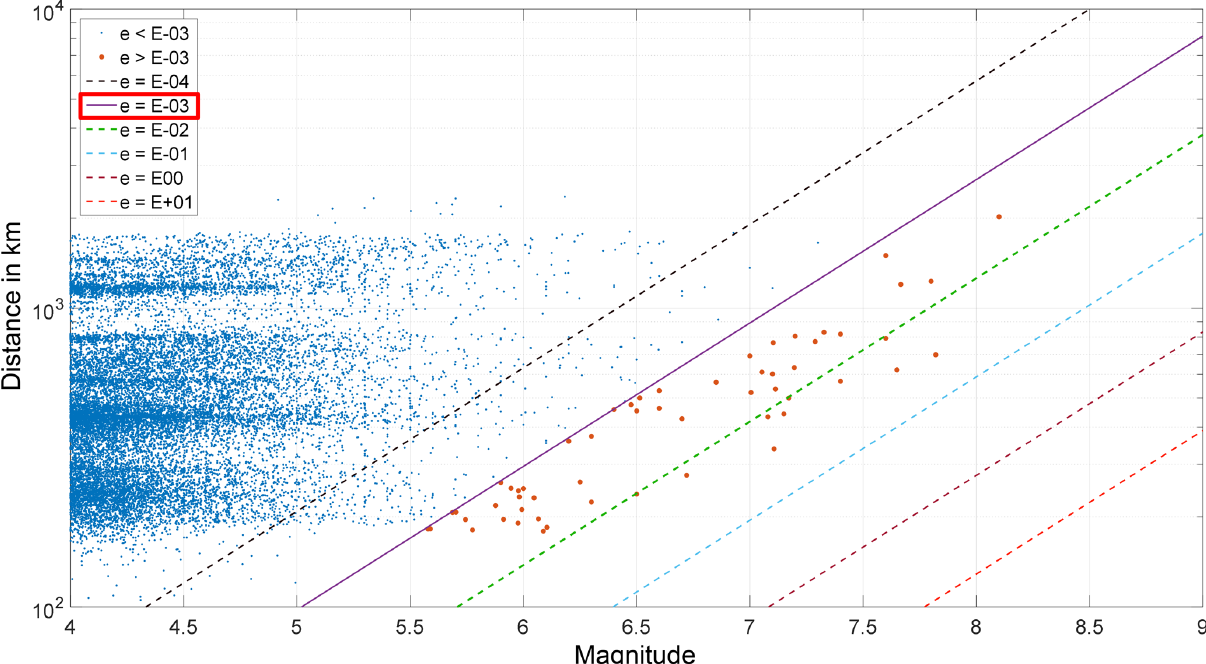
Figure 3. Distances of all earthquakes with a magnitude above 4 vs. their semi-logarithmic magnitude. The diagonals are lines of equal seismic energy density. About 0.3% of all recorded earthquakes ( n = 56) are above the threshold for potential water level changes with e >0.001Jm − 3 (red dots).